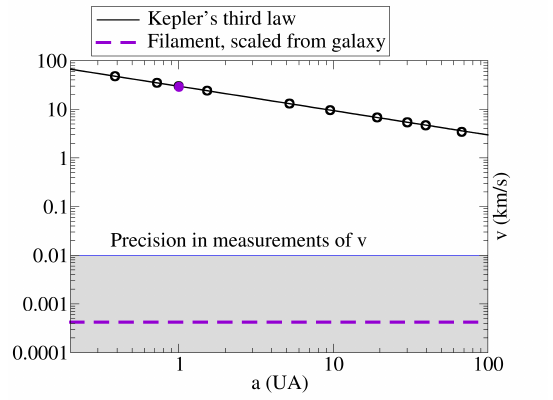
Figure 8. If the Tully–Fisher relation was an exact law and dark matter filaments were somehow attached to luminous matter, extrapolation of the flat rotation velocity (dashed line) from galaxy to solar mass would make the resulting velocity contribution too small to be detected: it lies well below Kepler’s curve and the achieved precision in measuring planet